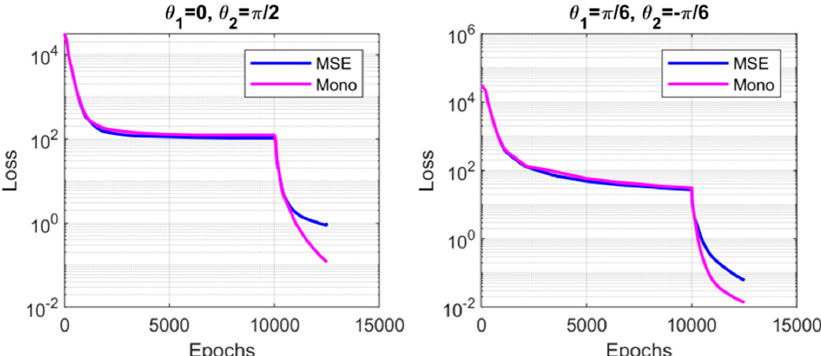
Figure 14. Loss history of PINN for case 3.